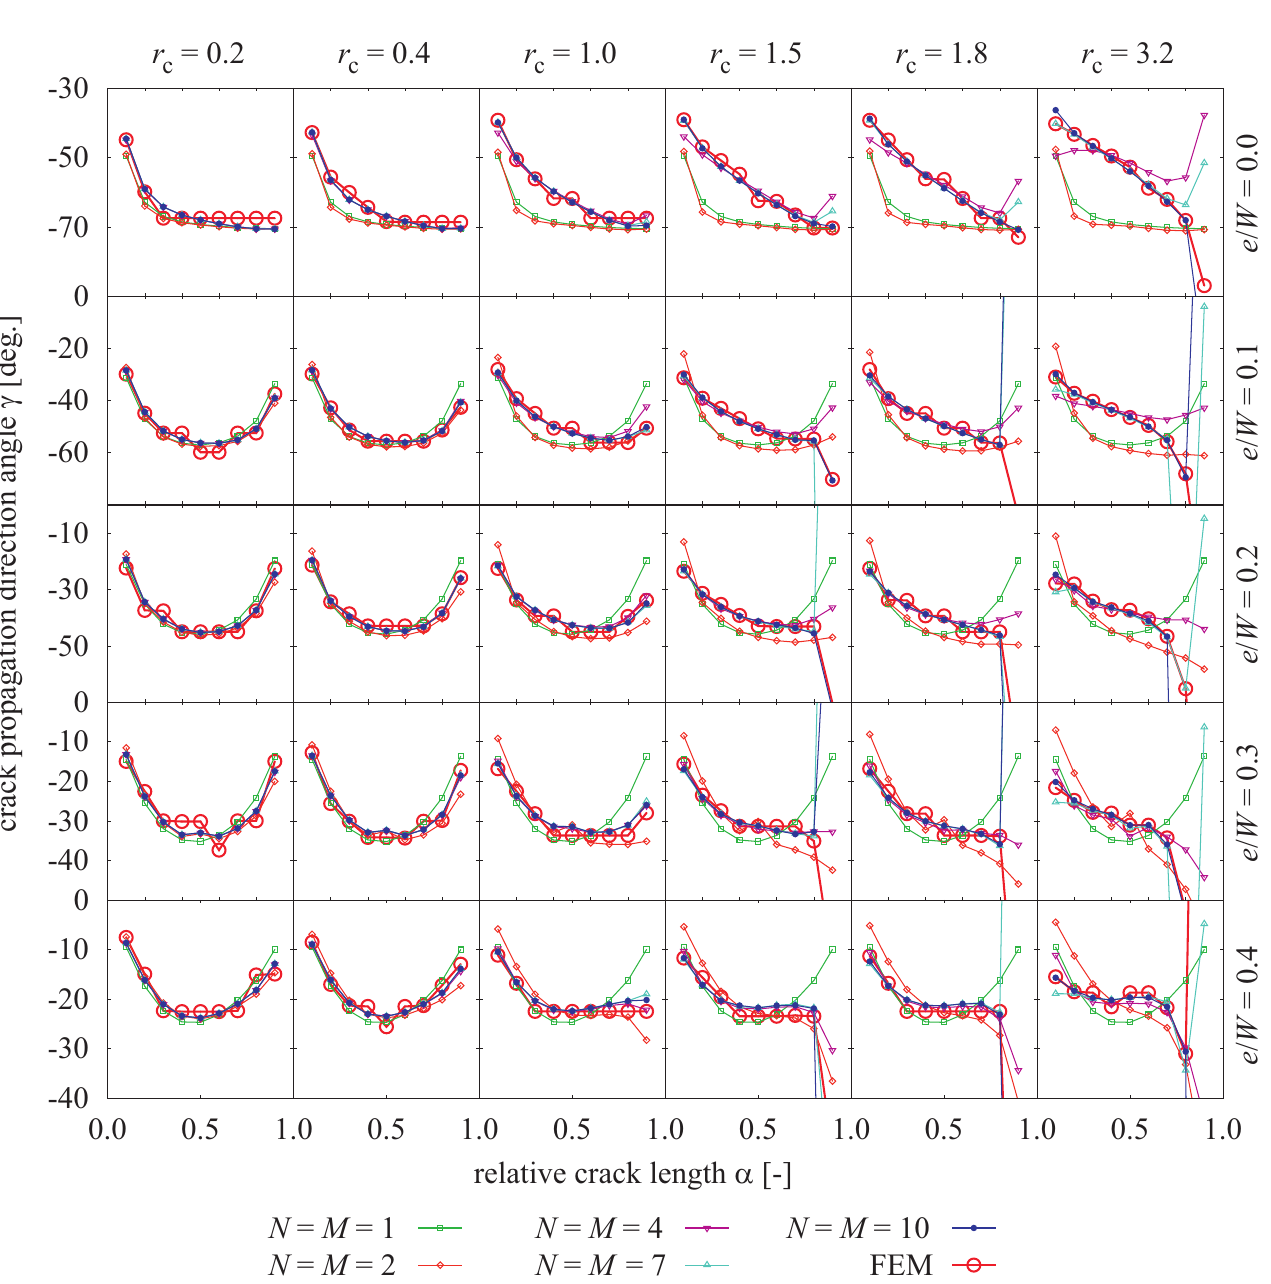
Figure 2: Dependences of the initial crack propagation direction angle γ on the relative crack length  for various relative crack eccentricities e / W obtained from the MTS fracture criterion at various radial distances from the crack tip r c ; the purely numerical results ("FEM") are compared to the semi-analytical results (" N = M = 1, 2, 4, 7 and 10") calculated via the multi-parameter form of the fracture